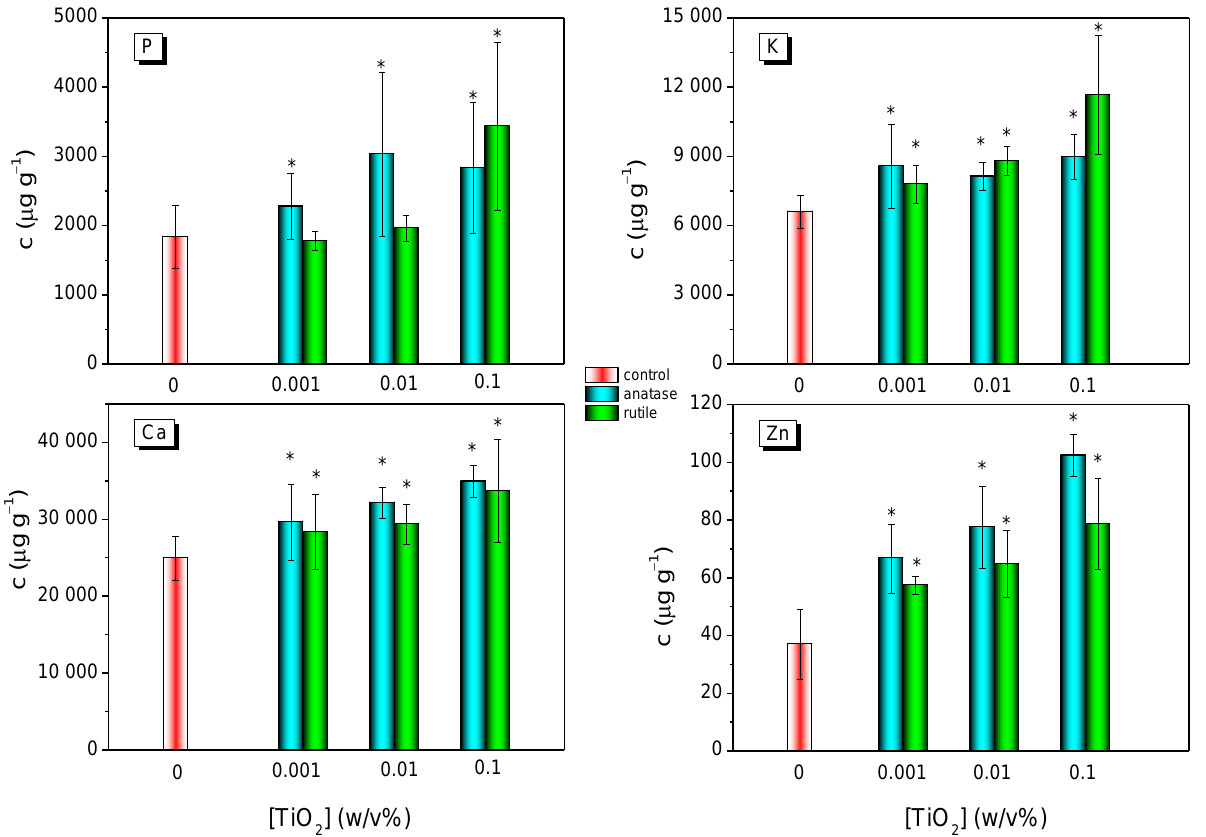
Figure 3. Level of P, K, Ca, and Zn elements in Cabernet Sauvignon leaf samples with and without MW-A or MW-R treatments using 0.001%, 0.01%, or 0.1% aqueous dispersions. * significant differ- ence compared to control ( p ≤ 0.05).